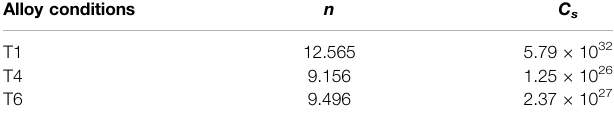
TABLE 2 | Material constants of the alloy in different conditions.